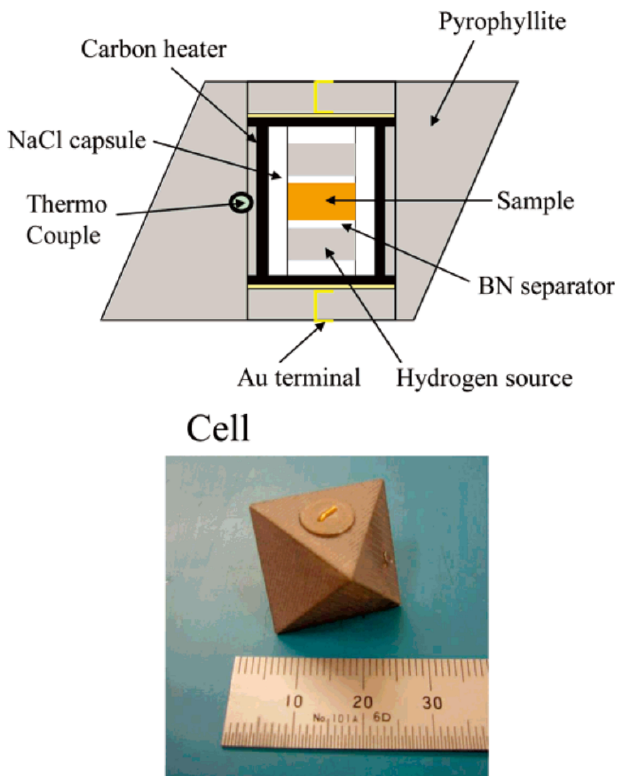
Figure 6. Illustration and photograph of the ultra-high-pressure cell assembly. Reproduced with permission [142]. Copyright 2007, American Chemical Society.